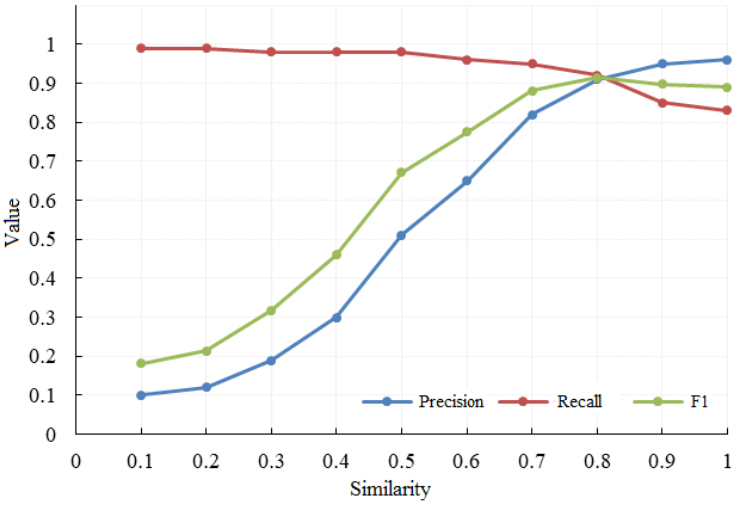
Figure 8. POI matching performance by using the name similarity.